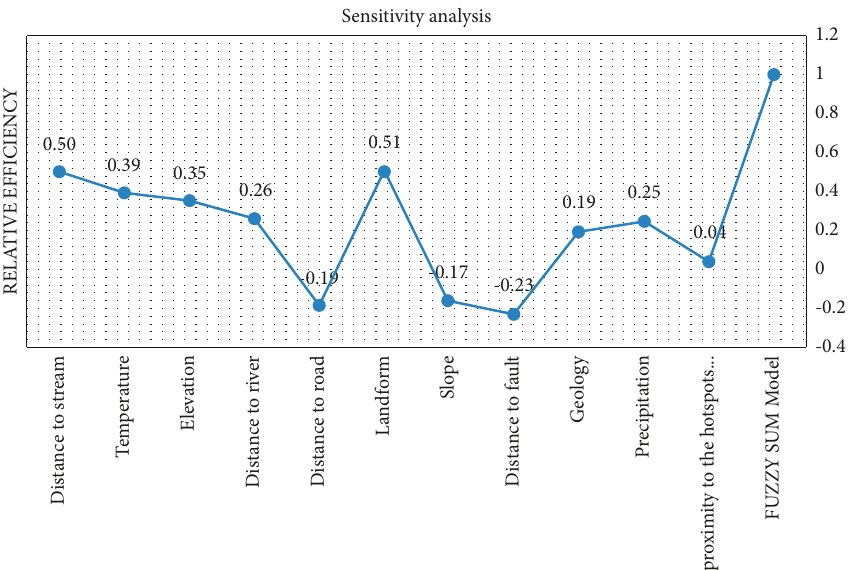
Figure 7: Sensitivity analysis of the propped FAHP.